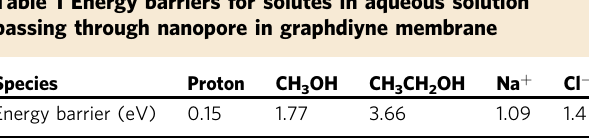
Table 1 Energy barriers for solutes in aqueous